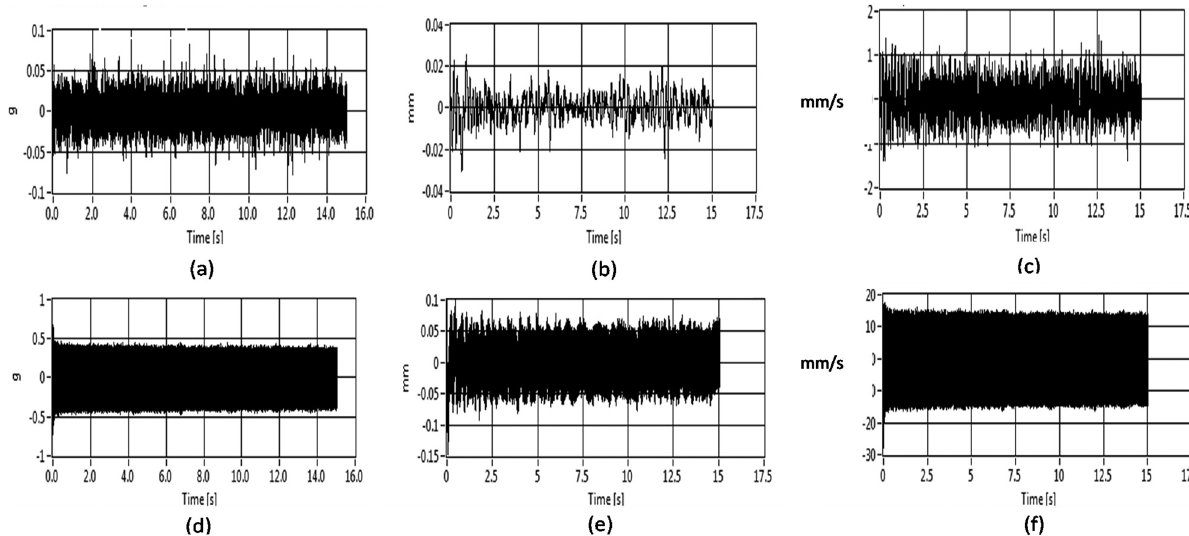
Figure 4: Variation in the amplitude of acceleration, displacement, and velocity with time measured at the surface of foundation embedment ( 0.5H ) . ( a ) Vertical acceleration, a ( b ) vertical displacement, Az; ( c ) vertical velocity, Vz; ( d ) horizontal acceleration, a z ; displacement, Ay; and ( f ) horizontal velocity, Vy.